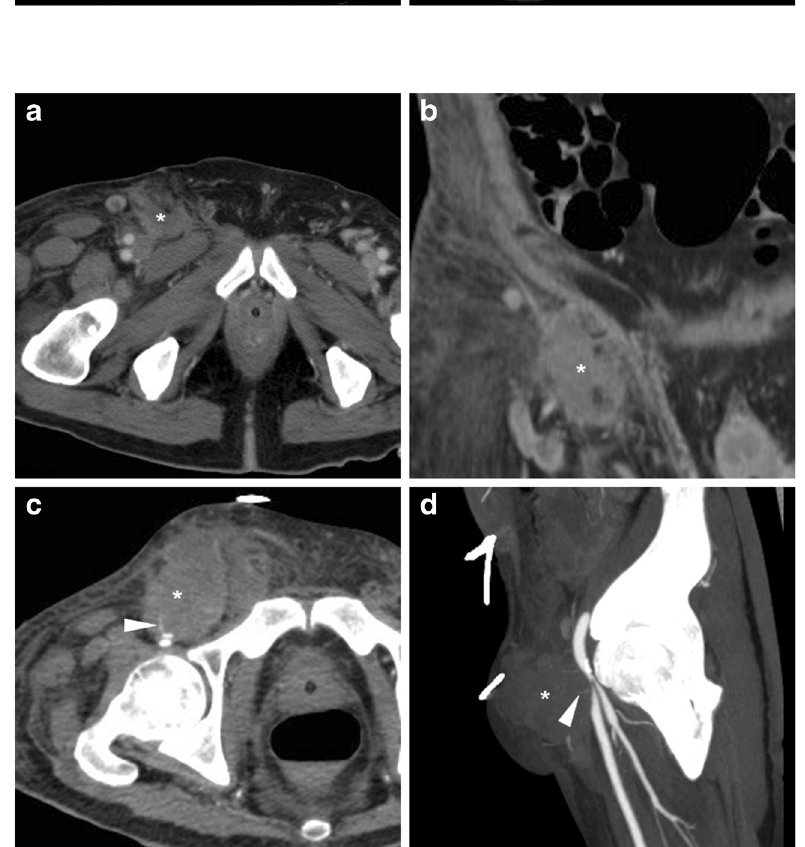
Fig. 1 Expected CT appearance following uncomplicated percutaneous access to the right common femoral artery (CFA) in two different patients. In an 82- year-old diabetic female patient, 48 h after coronary angiography (CA) and coronary artery stenting, focused precontrast (A) and arterial-phase (B) CT images showed mild fat stranding and fluid (thin arrows) along the probable puncture tract, abutting the ventral aspect of the calcified but patent CFA (arrowheads). The day after CA, in a 90-year-old fe- male patient, CT-angiography (C, D) showed similar changes (thin arrows) surrounding the CFA (arrowhead) and high-attenuation fascial blood (arrows), which did